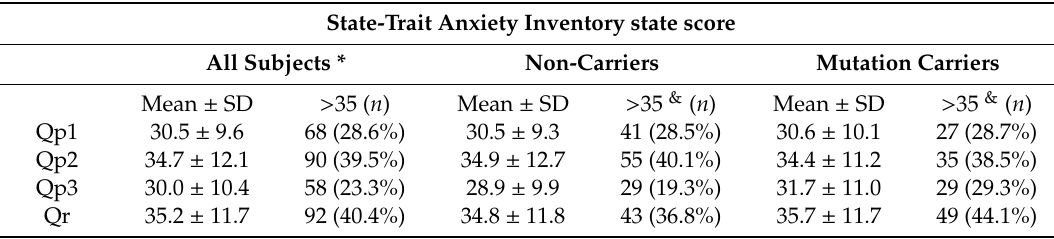
Table 3. State-Trait Anxiety Inventory state score over time.